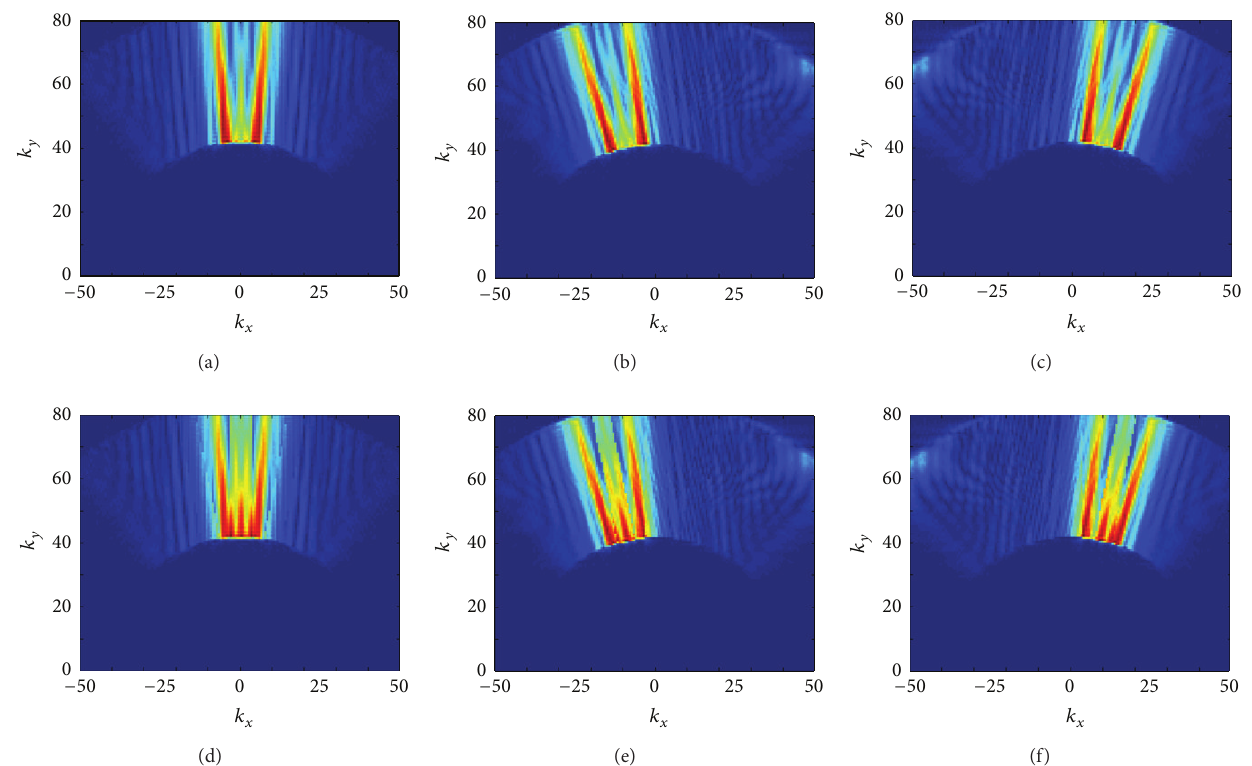
Figure 15: By dividing the imaging area into several subregions, the spatial spectrum for each target is obtained. (a–c) The gapped spatial spectrum for three targets, namely, P1, P2, and P3, respectively. (e-f) The extrapolated spatial spectrum for each target, that is, P1, P2, and